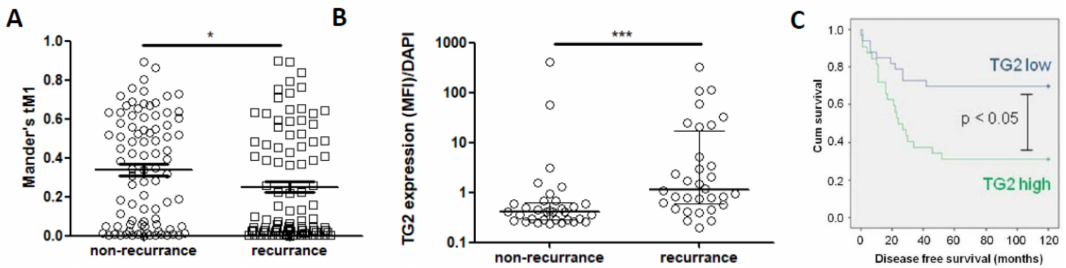
Figure 8. TG2 associates with poorer prognosis in CRC patients. Co-localisation of TG2 and LOX was significantly lower in patients with recurrence of disease ( A ). However, TG2 expression alone was significantly higher in patients with recurrence of disease ( B ), and high expression of TG2 was significantly associated with lower 5-year survival rates ( C ). * p < 0.05, ** p <